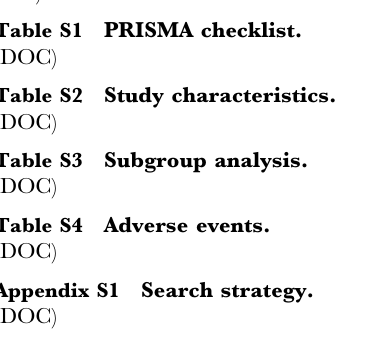
Figure S1 Quality assessment of